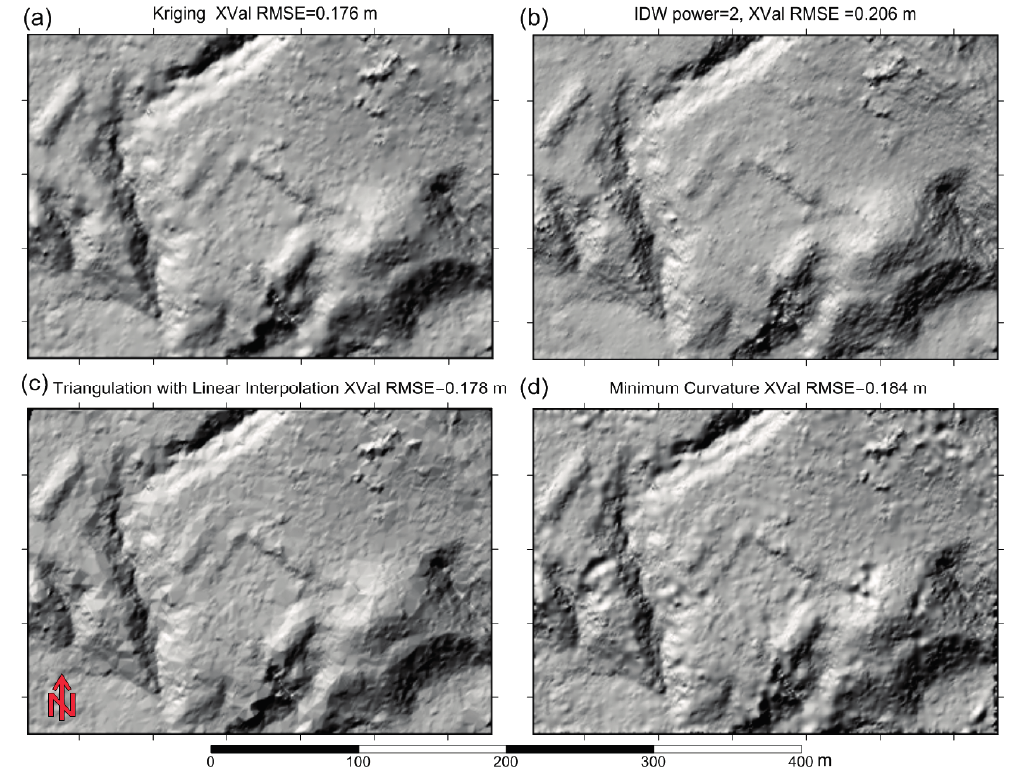
Figure 21. Shaded relief map of DEMs generated with different interpolation methods ( a ) Kriging; ( b ) Inverse distance weighting to a power (IDW); ( c ) Triangulation with linear interpolation; ( d ) Minimum